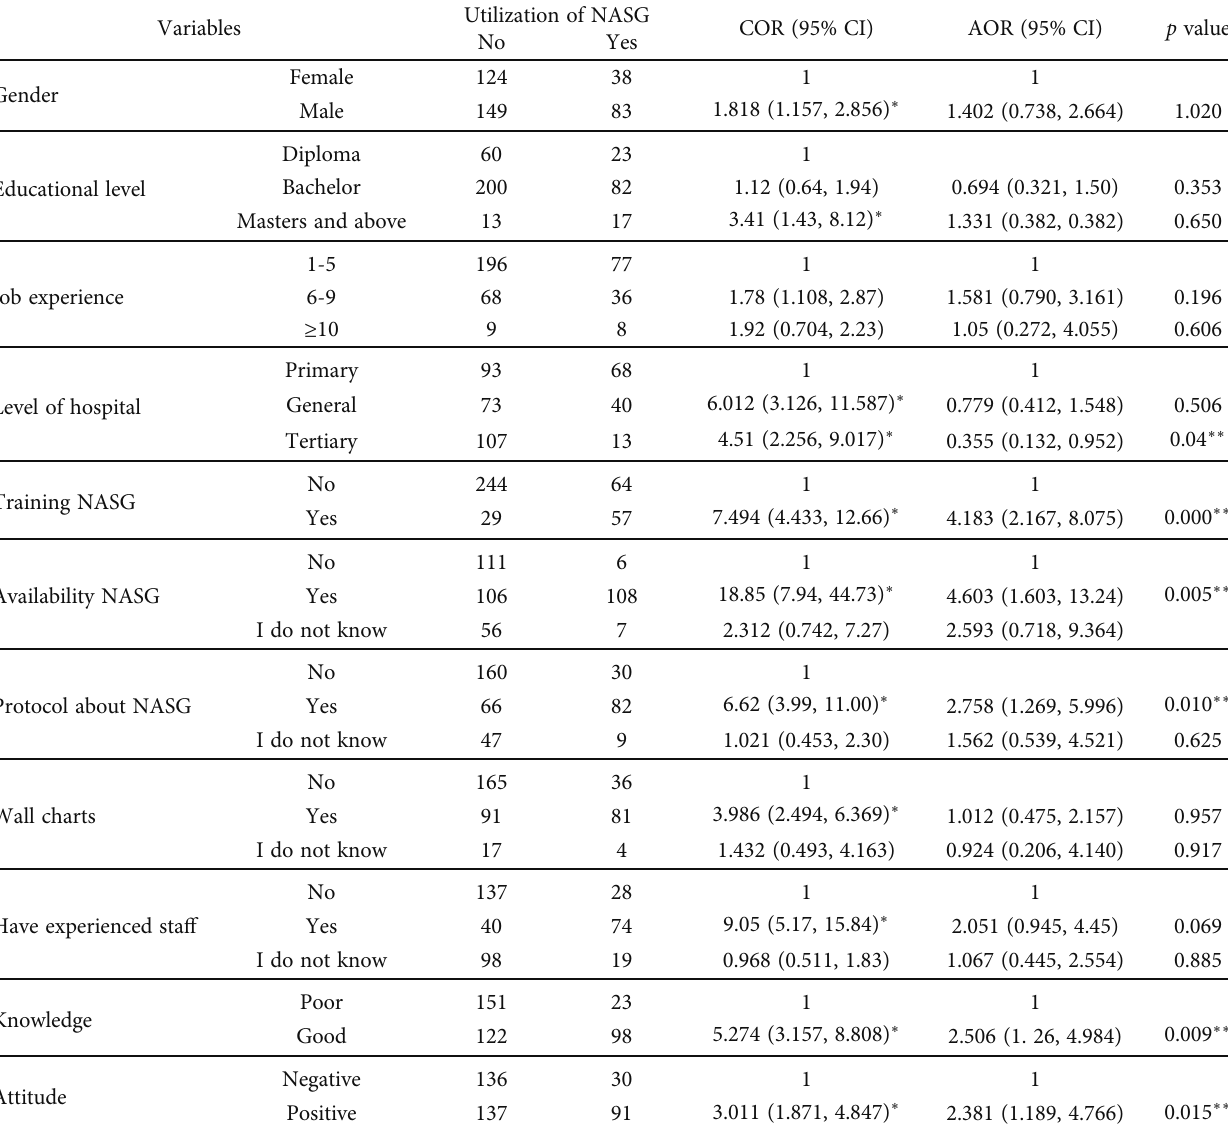
Table 6: Bivariable and multivariable logistic regression analyses for factors associated with the utilization of nonpneumatic antishock garments among obstetric care providers in public health facilities of Sidama region, Ethiopia,